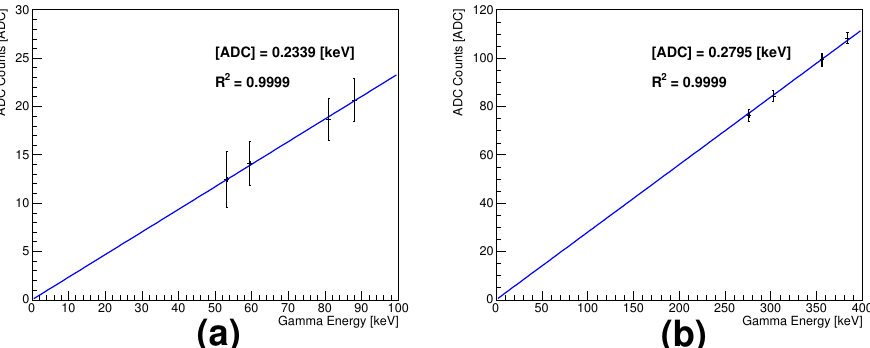
Figure 7. Linearity Between Measured ADC Counts and Low and Medium-energy Gammas: ( a ) 53.2, 59.5, 81, and 88 keV and ( b ) 276, 303, 356, and 384 keV.